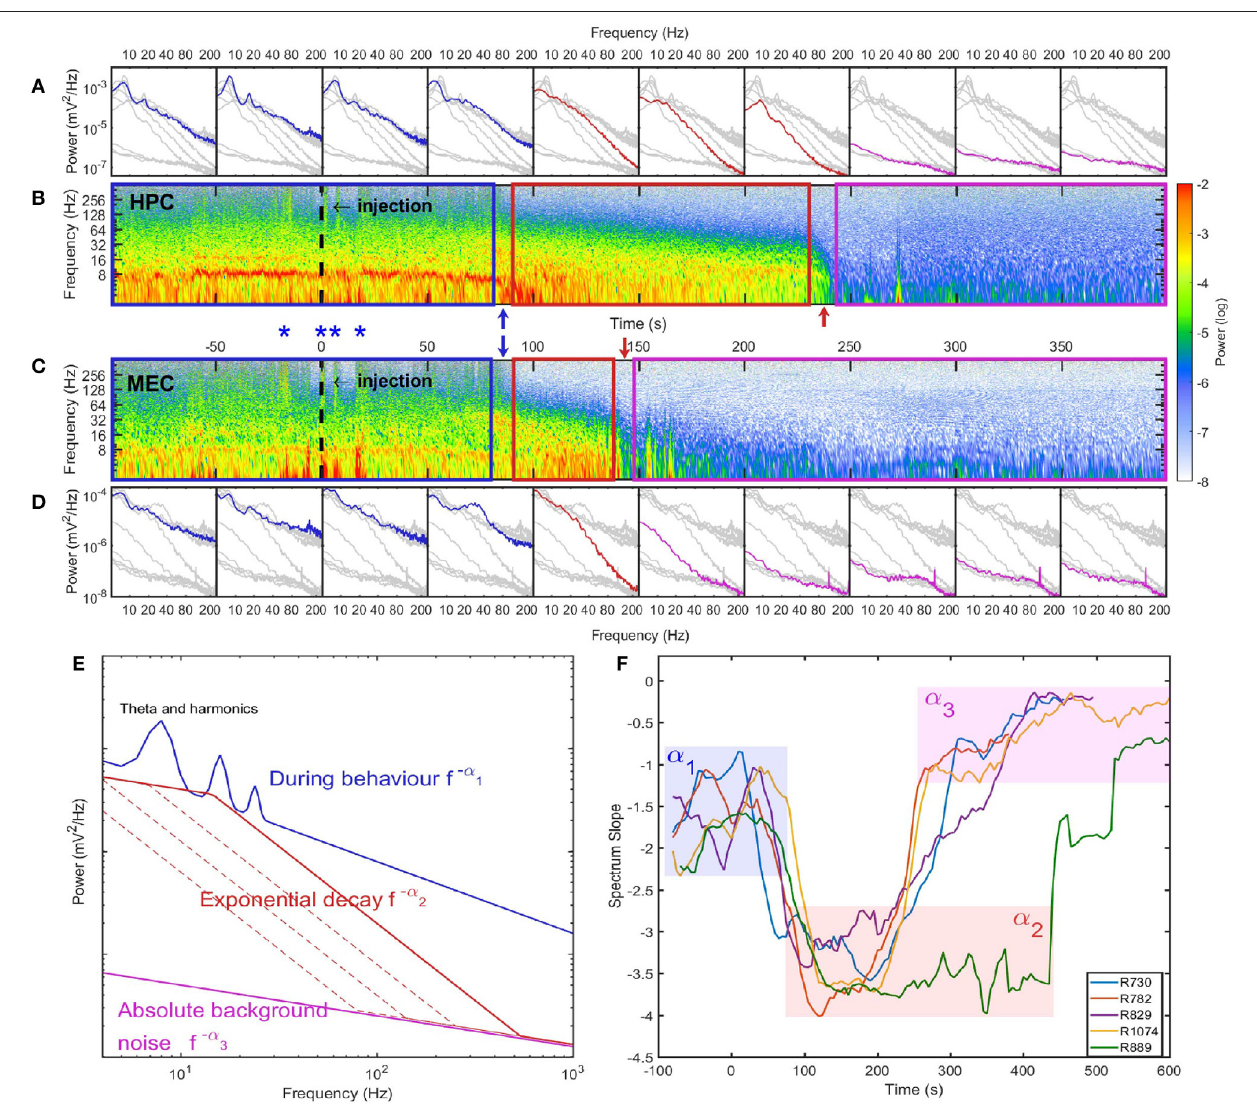
FIGURE 2 | Spectrum evolution during barbiturate overdose euthanasia. (A) The development of spectra estimated every 50 s. Spectra estimated within other time intervals were indicated as gray lines for comparison. (B) The spectrogram of hippocampal LFP where the injection time was marked as a dashed line at 0 s. The power in spectrogram was normalized by the maximum power during the euthanasia process. Based on the spectrogram and the development of power spectrum, we identified three stages during euthanasia: stage 1 was the pre-effective stage which included the pre-injection period and a short period after injection. This demarcated in the spectrogram as a blue box and in spectra, blue lines; stage 2 was the quasi-stationary decay stage marked as a red box in spectrogram and red lines in spectra; stage 3 was the quasi-white noise stage marked as a magenta box in spectrogram and magenta lines in spectra. Between these stages there were two rapid transition periods marked with blue and red arrows. (C) The spectrogram of LFP recorded in MEC. During stage 1, there were instances with strong high-frequency power ( > 128 Hz) both can be observed in HPC and MEC. Four of these instances were marked as blue asterisks. Given the consistency across regions, these high frequency bursts are most-likely related to sodium pentobarbital related muscle contractions (EMG artifact, see Supplementary Figure 3 ). (D) The development of spectra in MEC. Data from rat 782. (E) Cartoon illustrate the spectrum evolution during euthanasia. The spectra from the first to the third stages were marked as blue, red and magenta lines. The power spectra exhibits different slopes across stages. (F) Power-law exponents evolution of five rats estimated with window length of 40 s and time increment of 5 s. The spectrum slopes were estimated for the frequency range from 20 to 80 Hz in the log-log plot. Three stages can be identified with α 1 ≈ 1.5, α 2 ≈ 3.5, and α 3 ≈ 0.5. Note that rat 889 had longer stage 2 compared with other rats (see Supplementary Figure 6 ).